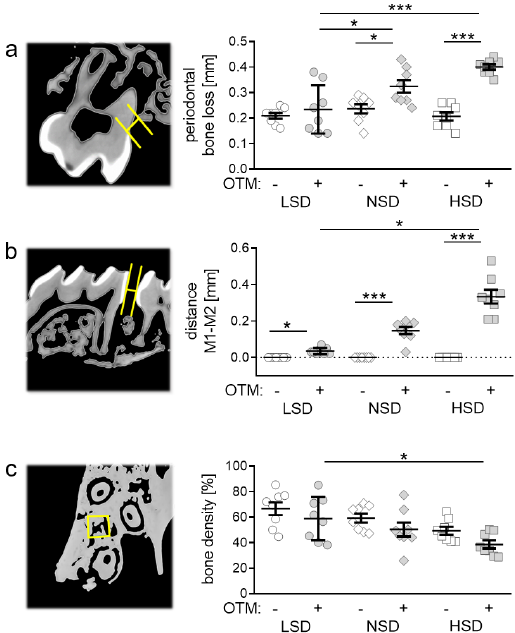
Figure 3. Analysis of periodontal bone loss ( a ), distance between the first (M1) and second (M2) upper molar ( b ) and bone density ( c ) after LSD, NSD or HSD, based on micro-computed tomogra- phy (µCT, n = 8). Symbols represent single data points, horizontal lines the arithmetic mean and vertical lines the standard error of the mean. AU: arbitrary units, OTM: orthodontic tooth movement, LSD: low salt diet, NSD: normal salt diet, HSD: high salt diet. Statistics: ANOVA followed by Holm–Sidak multiple comparison tests or Kruskal–Wallis test. * p < 0.05; *** p < 0.001.